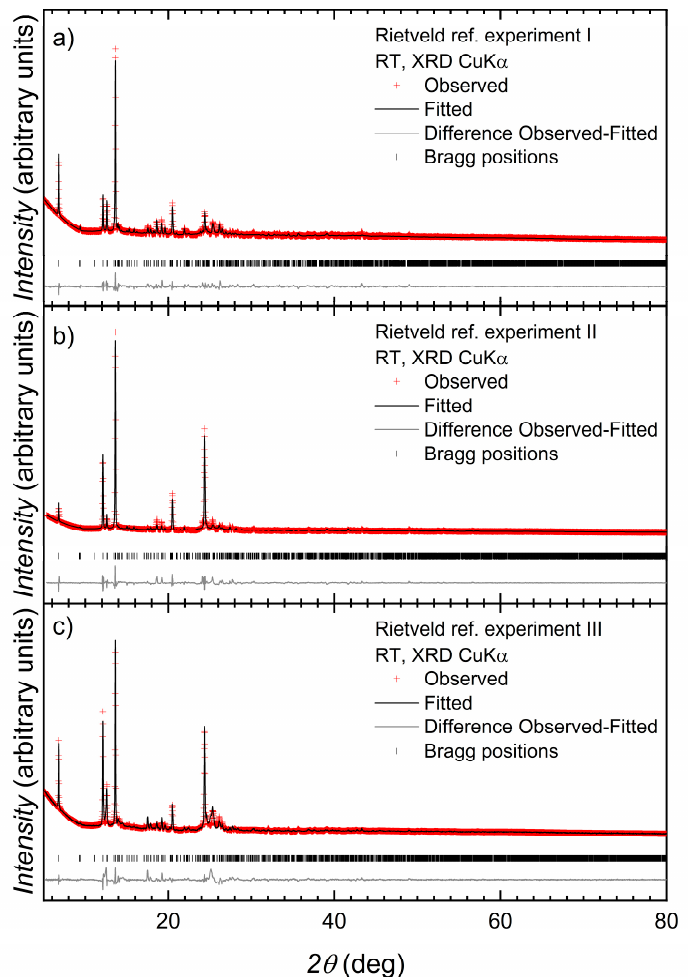
Figure 3. Laboratory X-ray diffraction (CuK α radiation) pattern (red crosses) for Experiments ( a ) I, ( b ) II, and ( c ) III (space group Pbca ) at room temperature. The black line corresponds to the best fit from the Rietveld refinement analysis. Lower vertical marks denote the Bragg peak positions. The bottom, grey line represents the difference between experimental and calculated points.